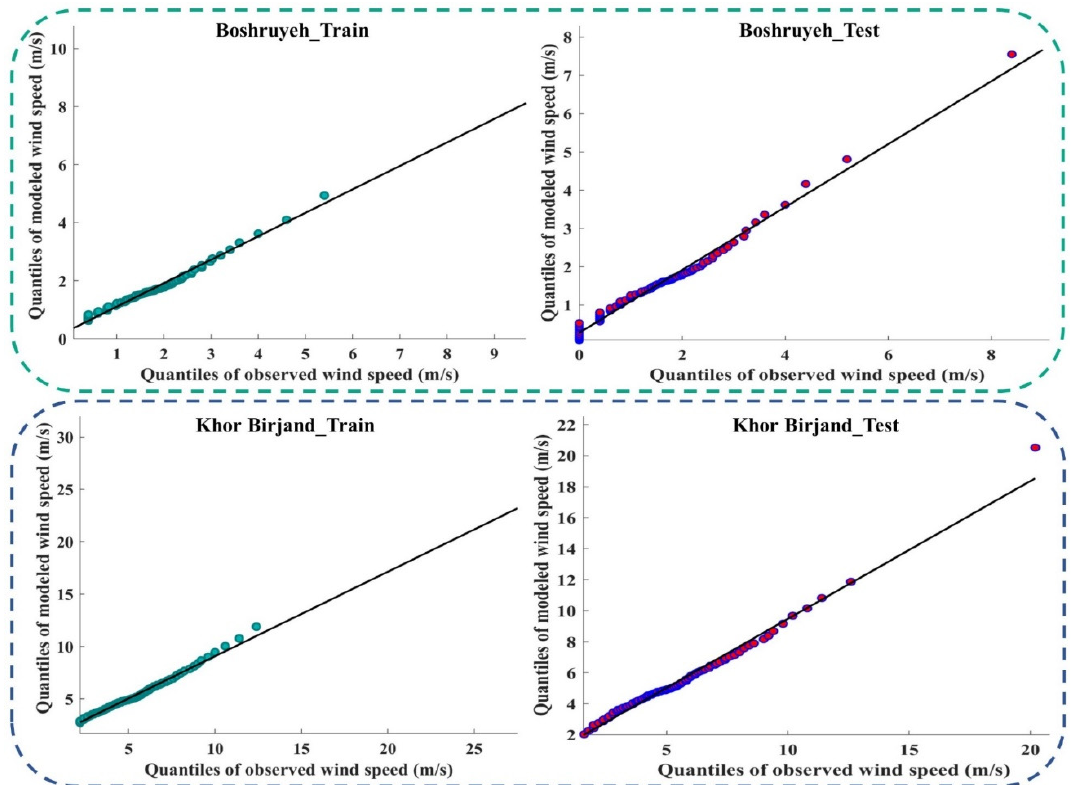
Figure A4. Q–Q plots of the observed and modeled values of WS using the meta-algorithm at different stations.